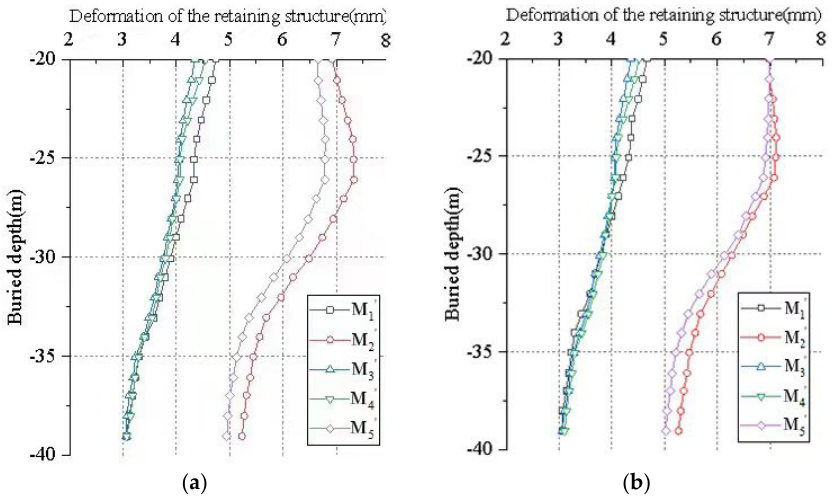
Figure 18. Deformation of retaining structure in pit-in-pit district. ( a ) working Condition 4. ( b ) working Condition 5.